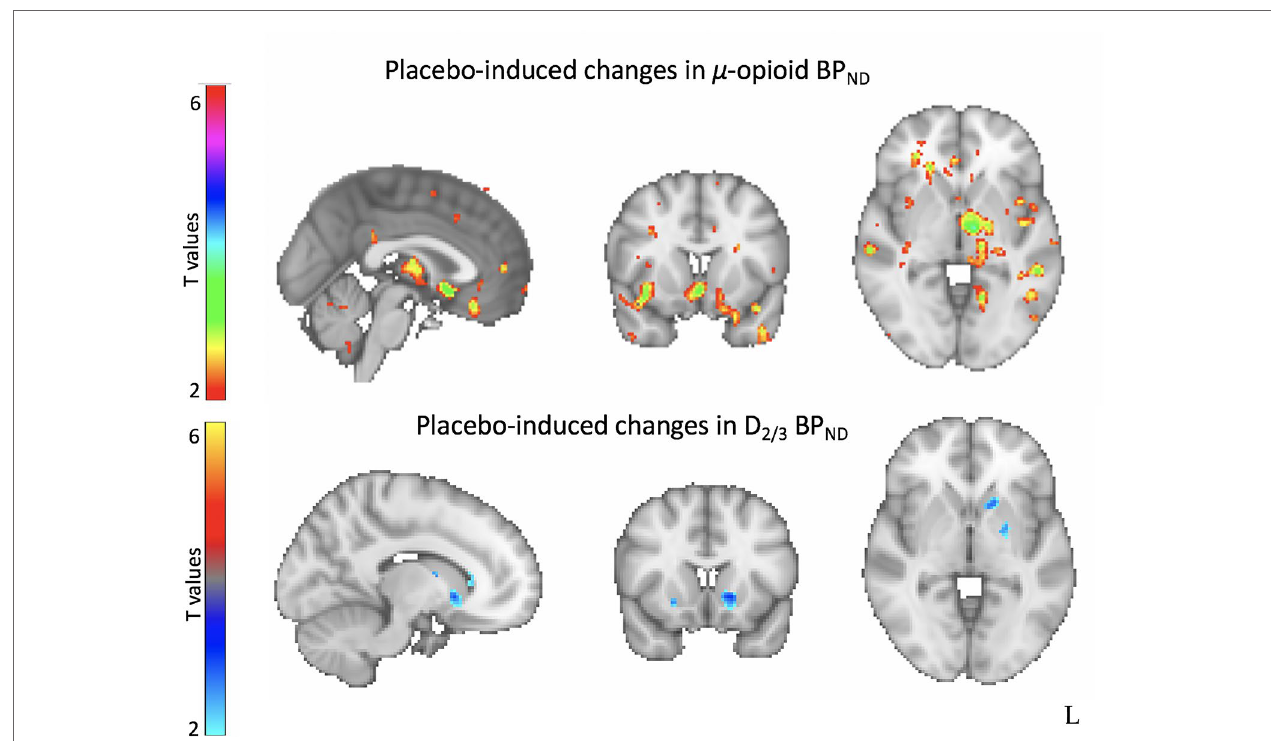
FIGURE 2 | Neural correlates of antidepressant placebo effects. Neuroimaging studies of antidepressant placebo effects using positron emission tomography (PET) have demonstrated increased placebo-induced µ-opioid neurotransmission in the subgenual anterior cingulate cortex (sgACC), the amygdala, the thalamus and the ventral striatum (top) and increased dopamine-induced neurotransmission in the ventral